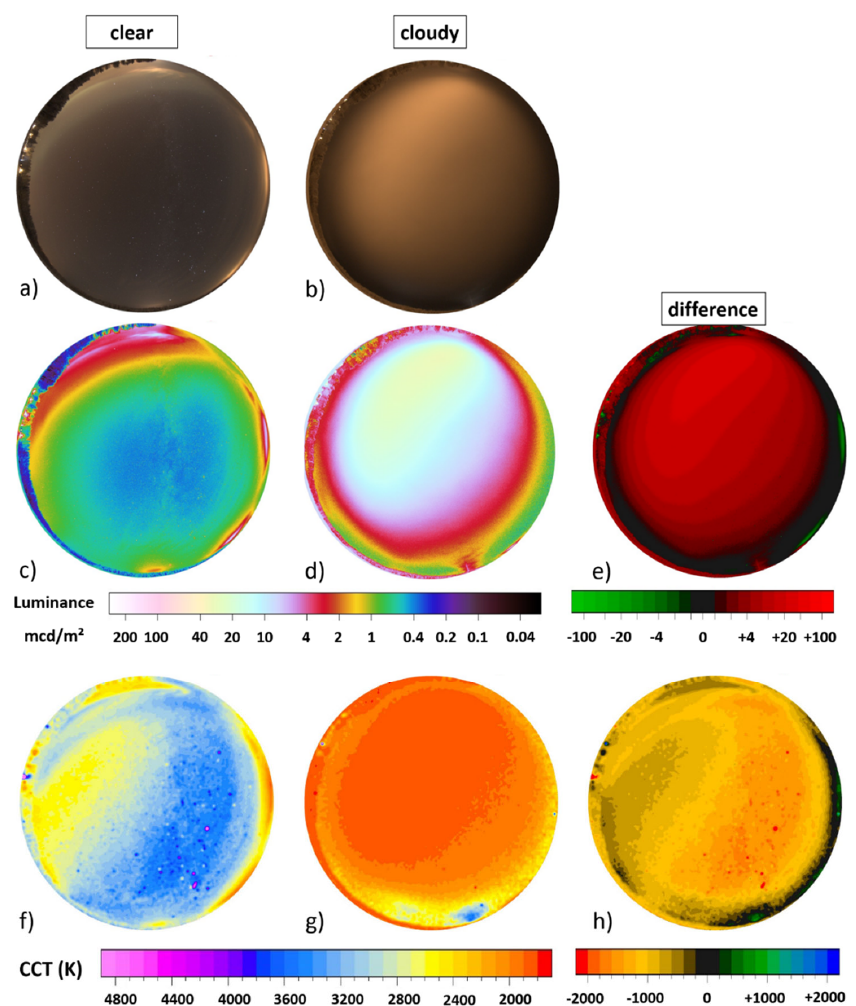
Figure 6. Imaging data taken during two winter nights in the subarctic village Portimo, Finland. Panels ( a , b ) show full-color RGB data, panels ( c – e ) luminance maps and panels ( f – h ) CCT maps. The left column ( a , c , f ) shows clear night data and the middle column ( b , d , g ) data from an overcast night. Right column ( e , h ) shows the di ff erence by subtracting clear from overcast night data. Table 2. List of parameters measured at zenith at the subarctic site in Portimo, Finland on two winter nights with di ff erent cloud cover and the same snow cover. (*) cloud amplification: Δ clouds = overcast, snow/clear, snow Clear, Snow Overcast, Snow Δ clouds (*) L v,zenith (mcd/m²) 0.5